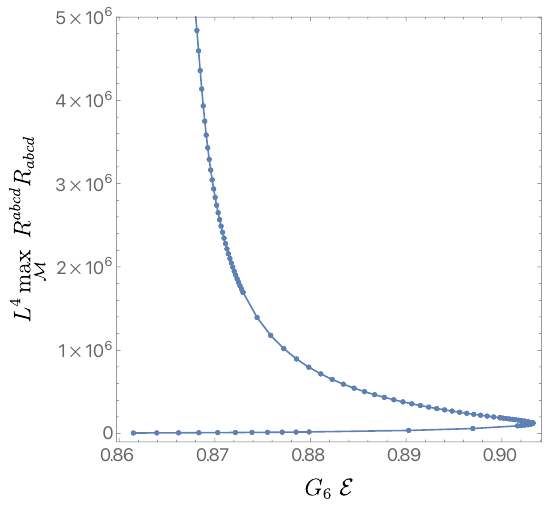
Figure 8 . Maximum value of the normalised Kretschmann scalar for black resonator strings as a function of E at fixed e Ω H = 0 . 5 . A turning point is clearly visible around G 6 E ≈ 0 . 903 . The apparent blow-up of the Kretschmann scalar suggests that the phase space of black resonator strings ends in a curvature